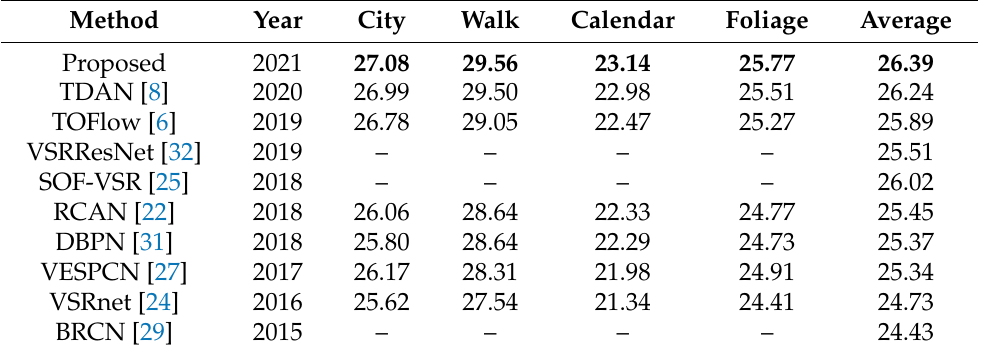
Table 2. Comparison of PSNR (dB) with state-of-the-art methods on Vid4 dataset with scaling factor of 4. The best methods results are shown in